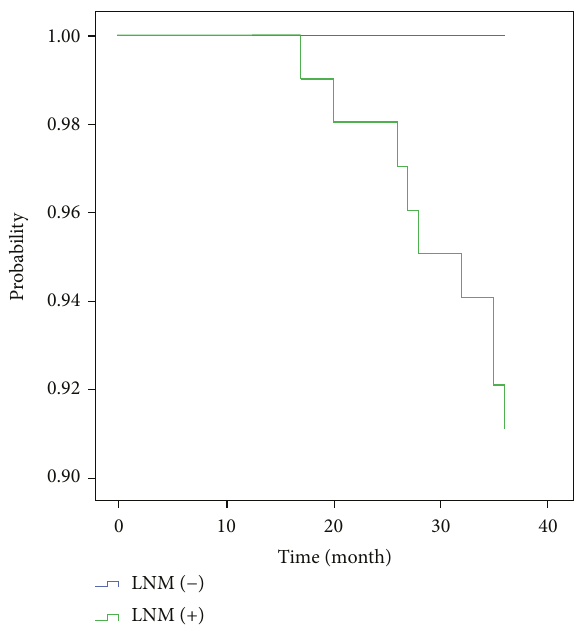
Figure 2: Three-year overall survival between the two